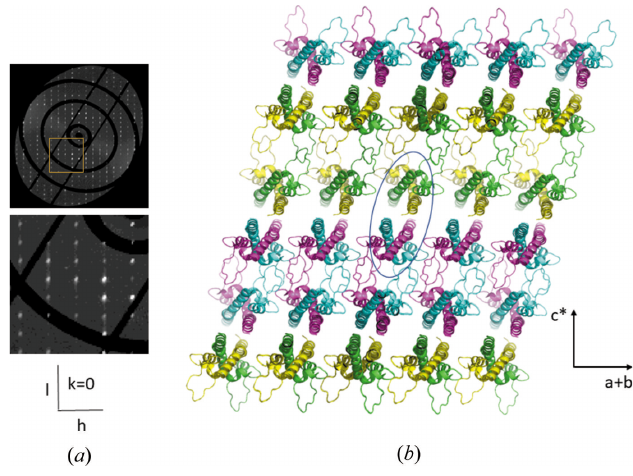
Figure 3 Diffuse scattering along c* . ( a ) Reciprocal space reconstruction of h 0 l layer and zoomed in at the area of the yellow box. Intensities are on the same scale as in Fig. 2( a ). Streaks are observed along c* , but much weaker than those along a* + b*. ( b ) Model of a single domain in which one layer is replaced by a rotation copy generated by the NCS rotation operation, which coincides with the twinning, i.e. 180 � rotation around a* + b* . The colouring of the chains is the same as in Fig. 1, but the asymmetric unit used here (indicated by an ellipse) is such that the loops are on the outside. Inclusion of a layer of rotated copies will disrupt the periodicity perpendicular to the ab layer which is the c* direction, leading to diffuse streaks in the diffraction pattern.